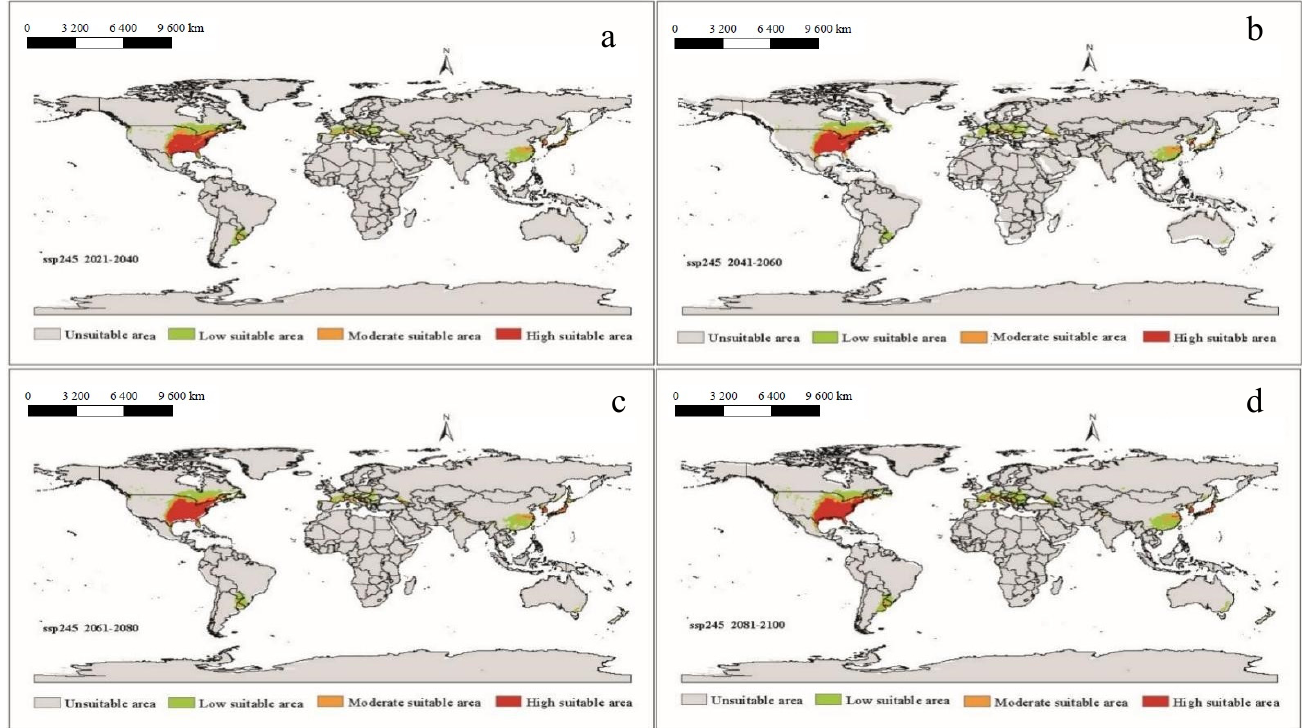
Figure 7. The potential distribution of suitable areas for A. americanum around the world under the climatic conditions of shared socio-economic pathway 2-4.5 (middle of the road and radiative forcing of 4.5 W/m 2 to 2100) during different periods of the 21st century: ( a ) 2021–2040, ( b ) 2041–2060, ( c ) 2061–2080, ( d ) 2081–2100.